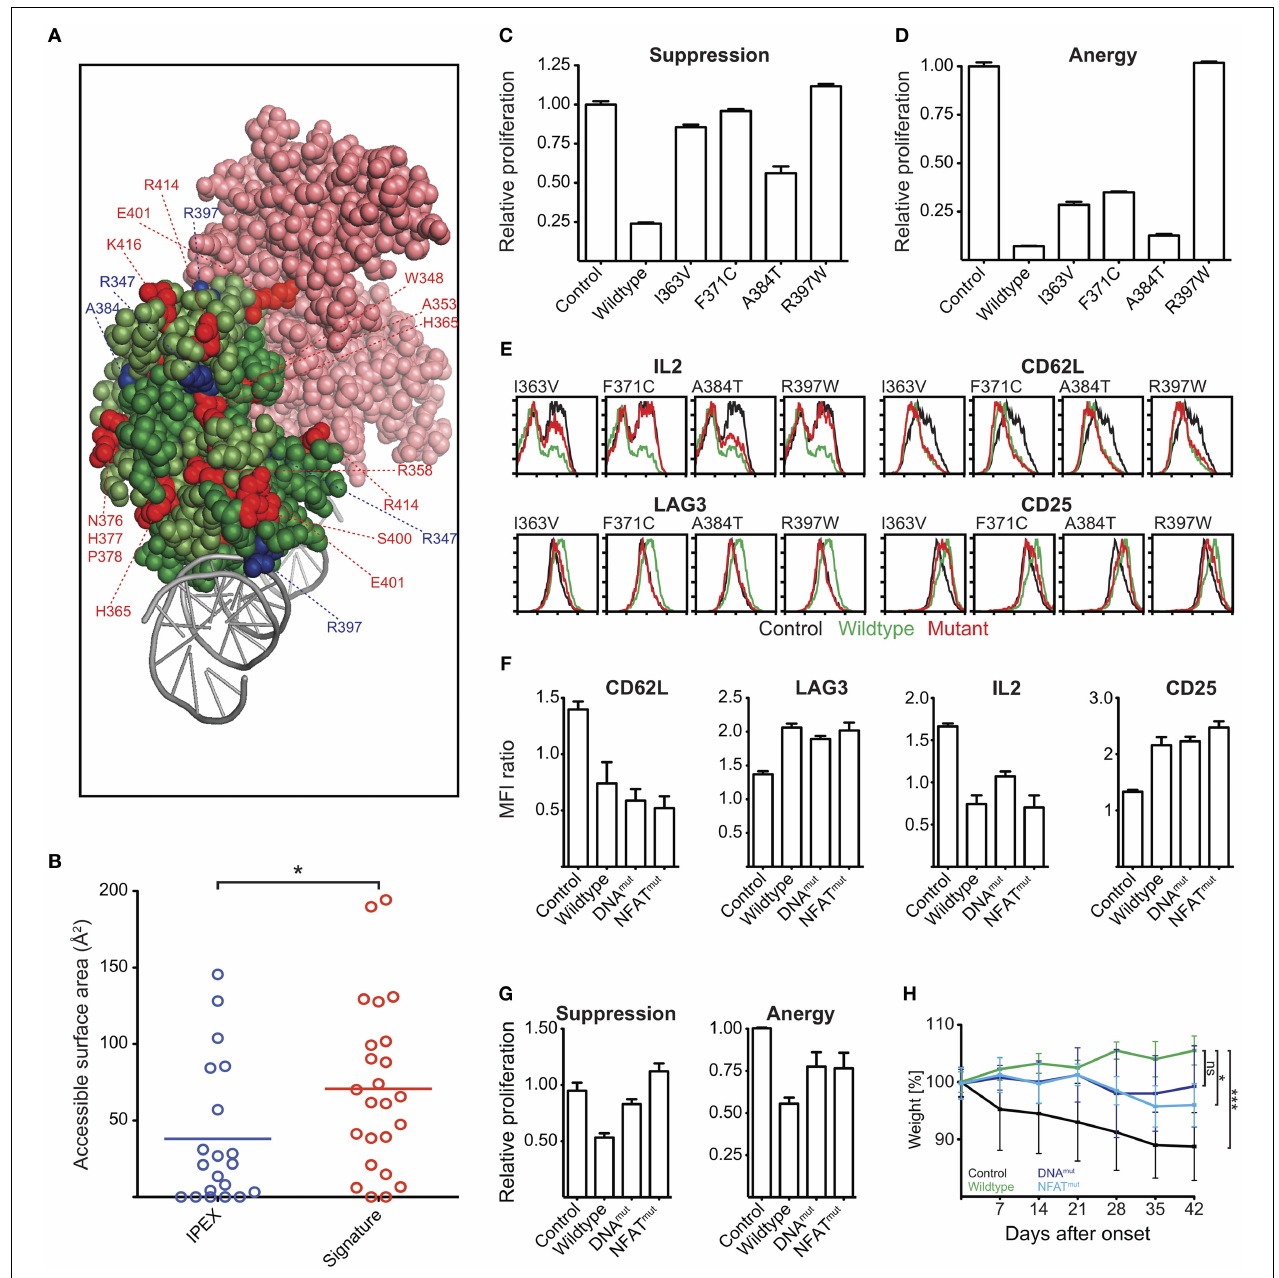
involved in NFAT interaction (NFAT mut with H365N and E401V) or influence DNA binding (DNA mut with N376R, H377N, P378A, I385V) or a deletion of the entire FKH ( Δ FKH) were created and expressed inT cells. As a control, the cells were transduced with an irrelevant control gene. (F) Bar graphs showing the mean fluorescence intensity (MFI) by FACS analysis of Foxp3 target genes in transduced cells as compared to the non-transduced cells within the same well (two independent experiments). (G) Suppressive activity and induction of anergy in the transducedT cells (two independent experiments). (H) The ability of the transduced cells to prevent weight loss caused by co-transferred “aggressor”T cells was measured by following the mean weight of the mice ( n ≥ 4 per group) normalized to their weight on the day of onset in control mice. P values determined by one-way ANOVA; ns, not significant; * ≤ 0.05, *** ≤ 0.001. Error-bars represent the